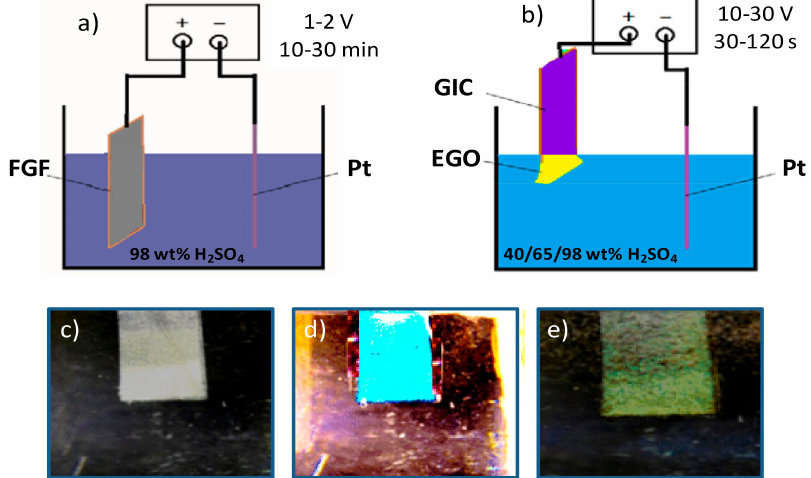
Figure 1. Top: Schematic representation of the electrolytic cells used for the synthesis of GO: ( a ) intercalation step, and ( b ) oxidation / exfoliation step. Bottom: Images of grey FGP ( c ), turquoise-blue GIC, ( d ) and yellowish synthesized EGO ( e